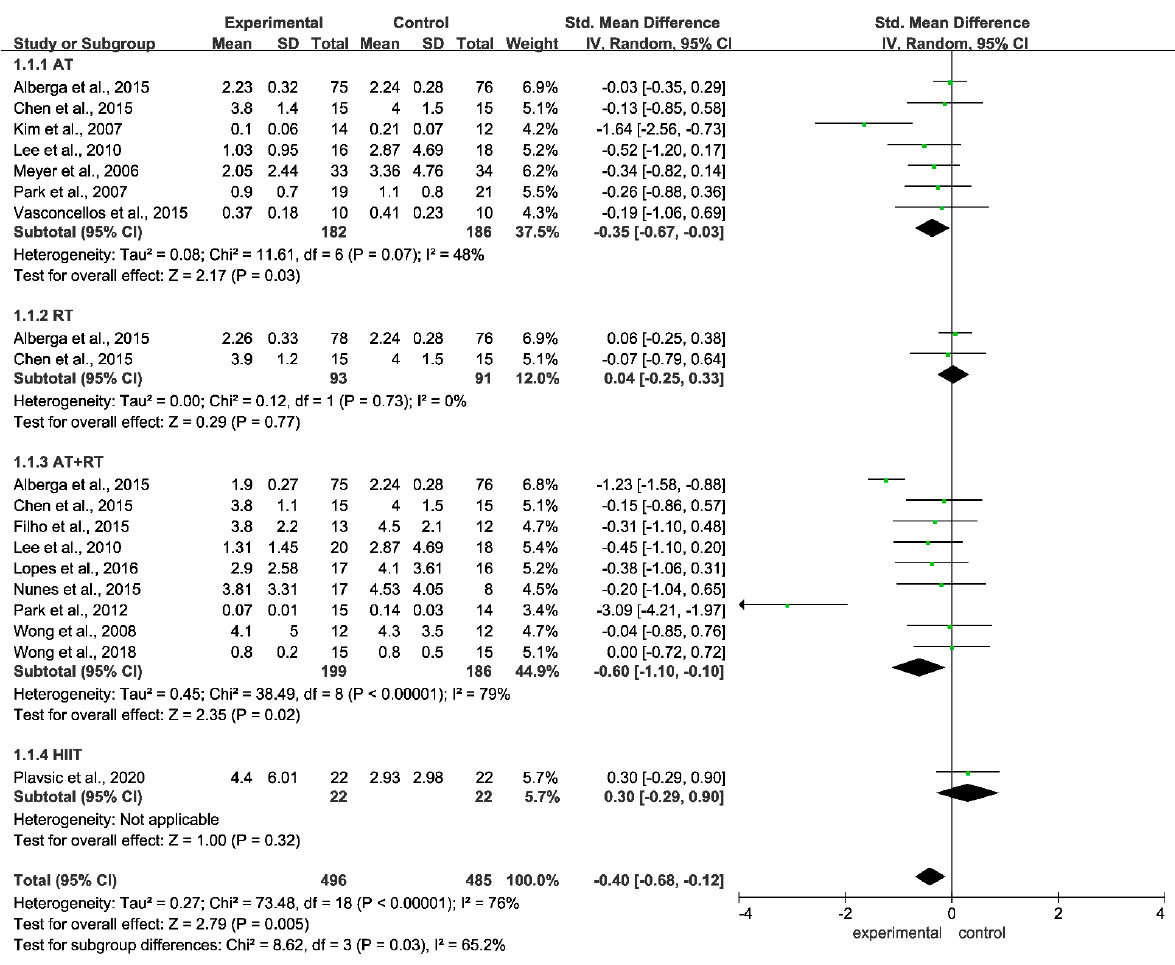
Figure 5. Meta-analysis of the effect of different training modalities on the level of CRP level in adolescents with obesity.